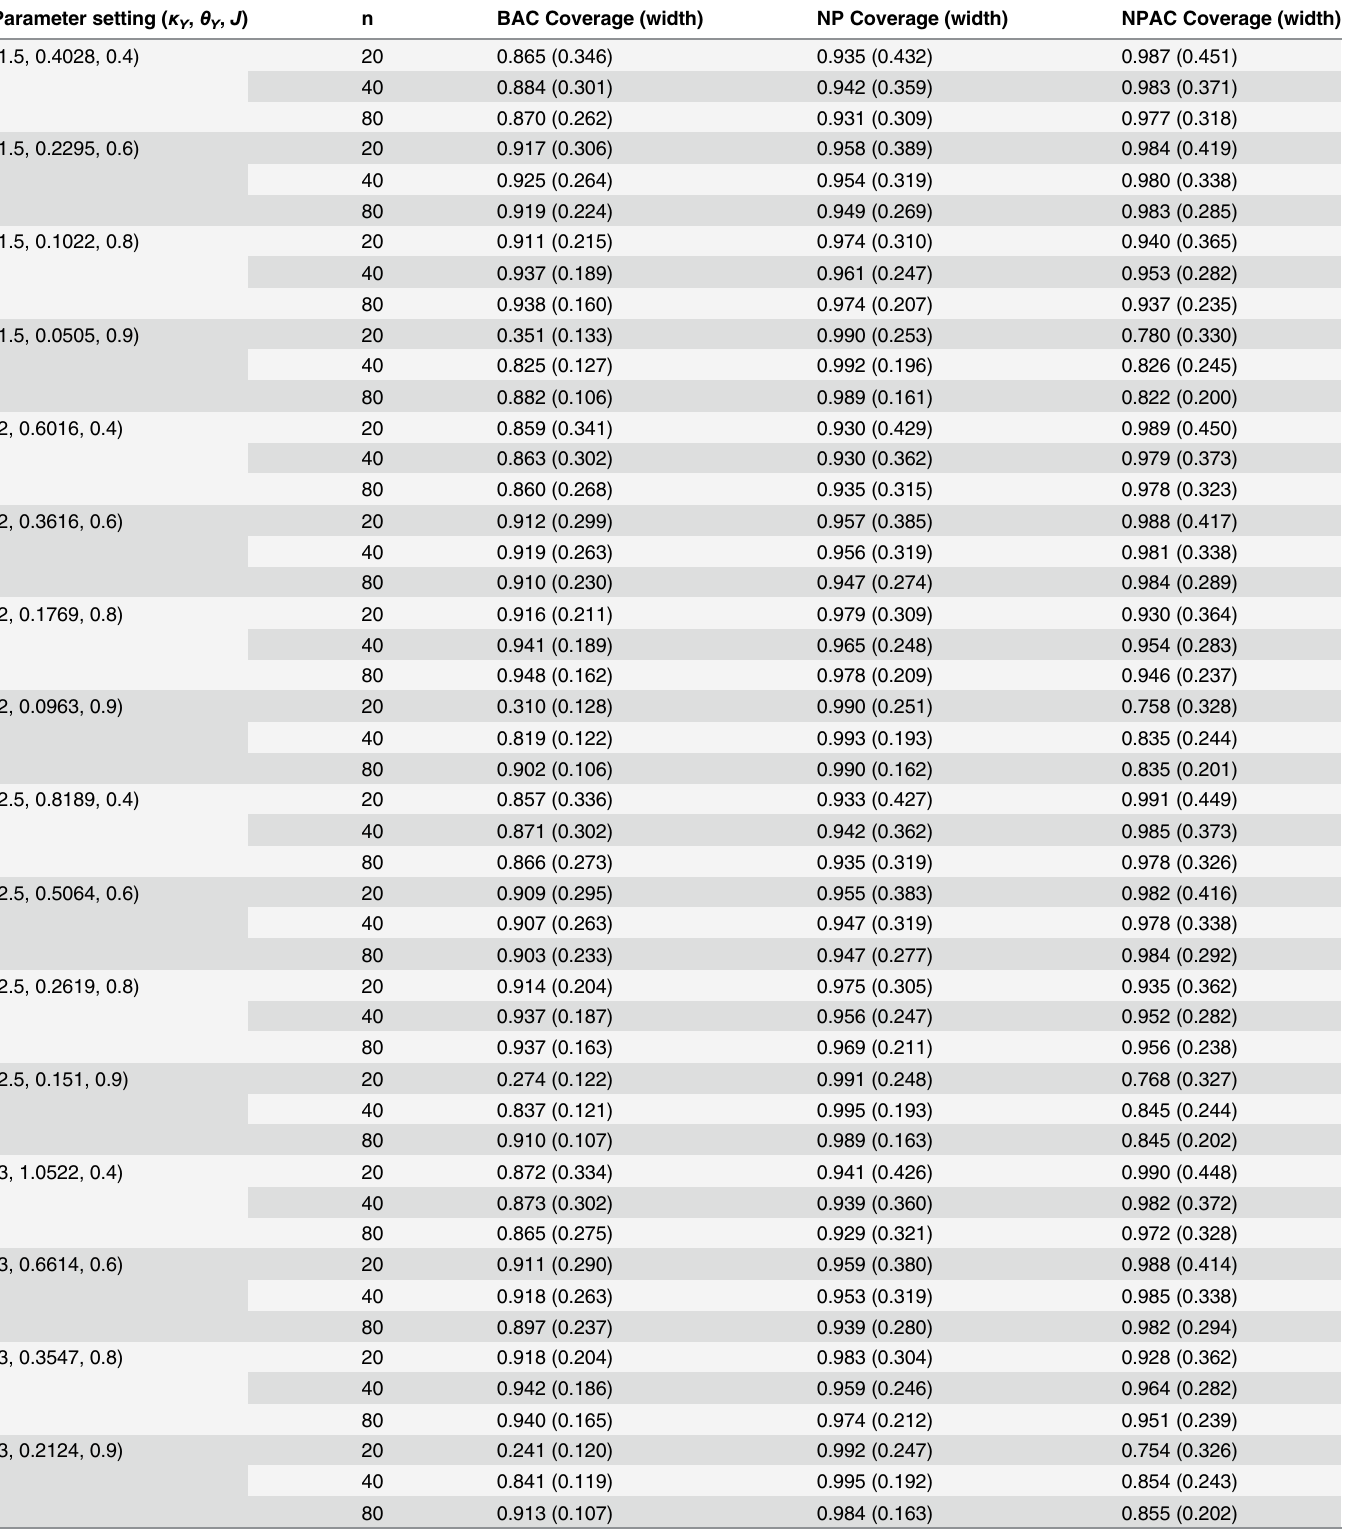
Table 6. Gamma distributions: coverage probabilities and average widths when m = 40 in the non-diseased group at the 95% nominal